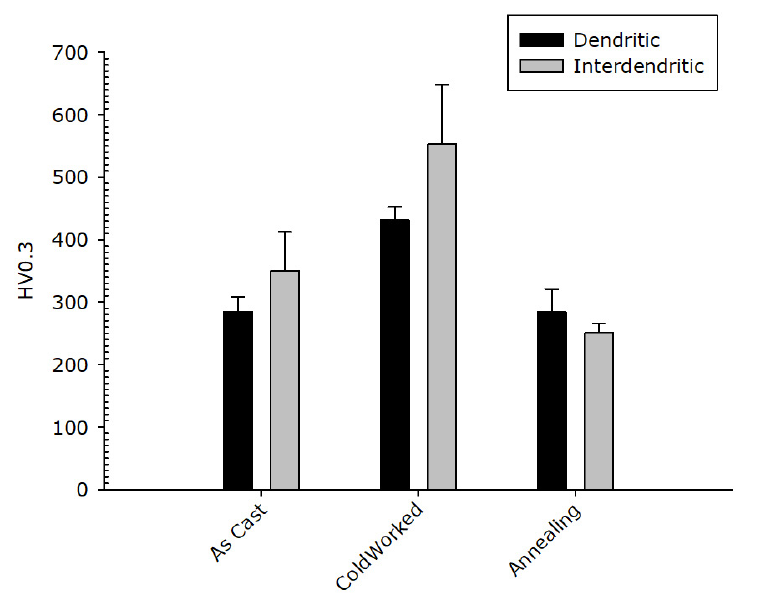
Figure 12. CoCrFeNiMnZr alloy: Micro-hardness value in the dendritic (black bar) and inter-dendritic (grey bar) zones.